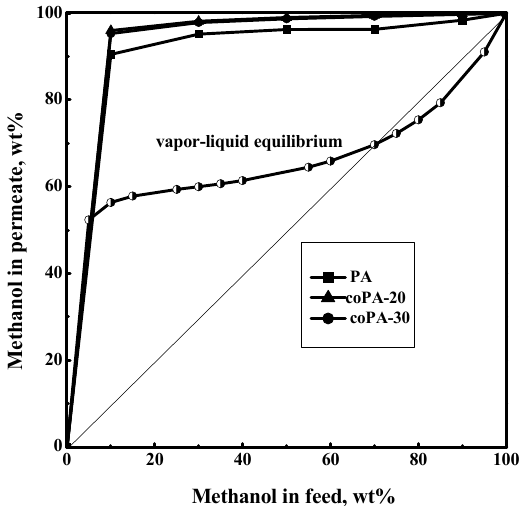
Figure 5. Dependence of methanol concentration in the permeate on methanol concentration in the feed for the pervaporation of a methanol–toluene mixture. Vapor–liquid equilibrium curve of methanol and toluene mixture, 760 mm Hg.